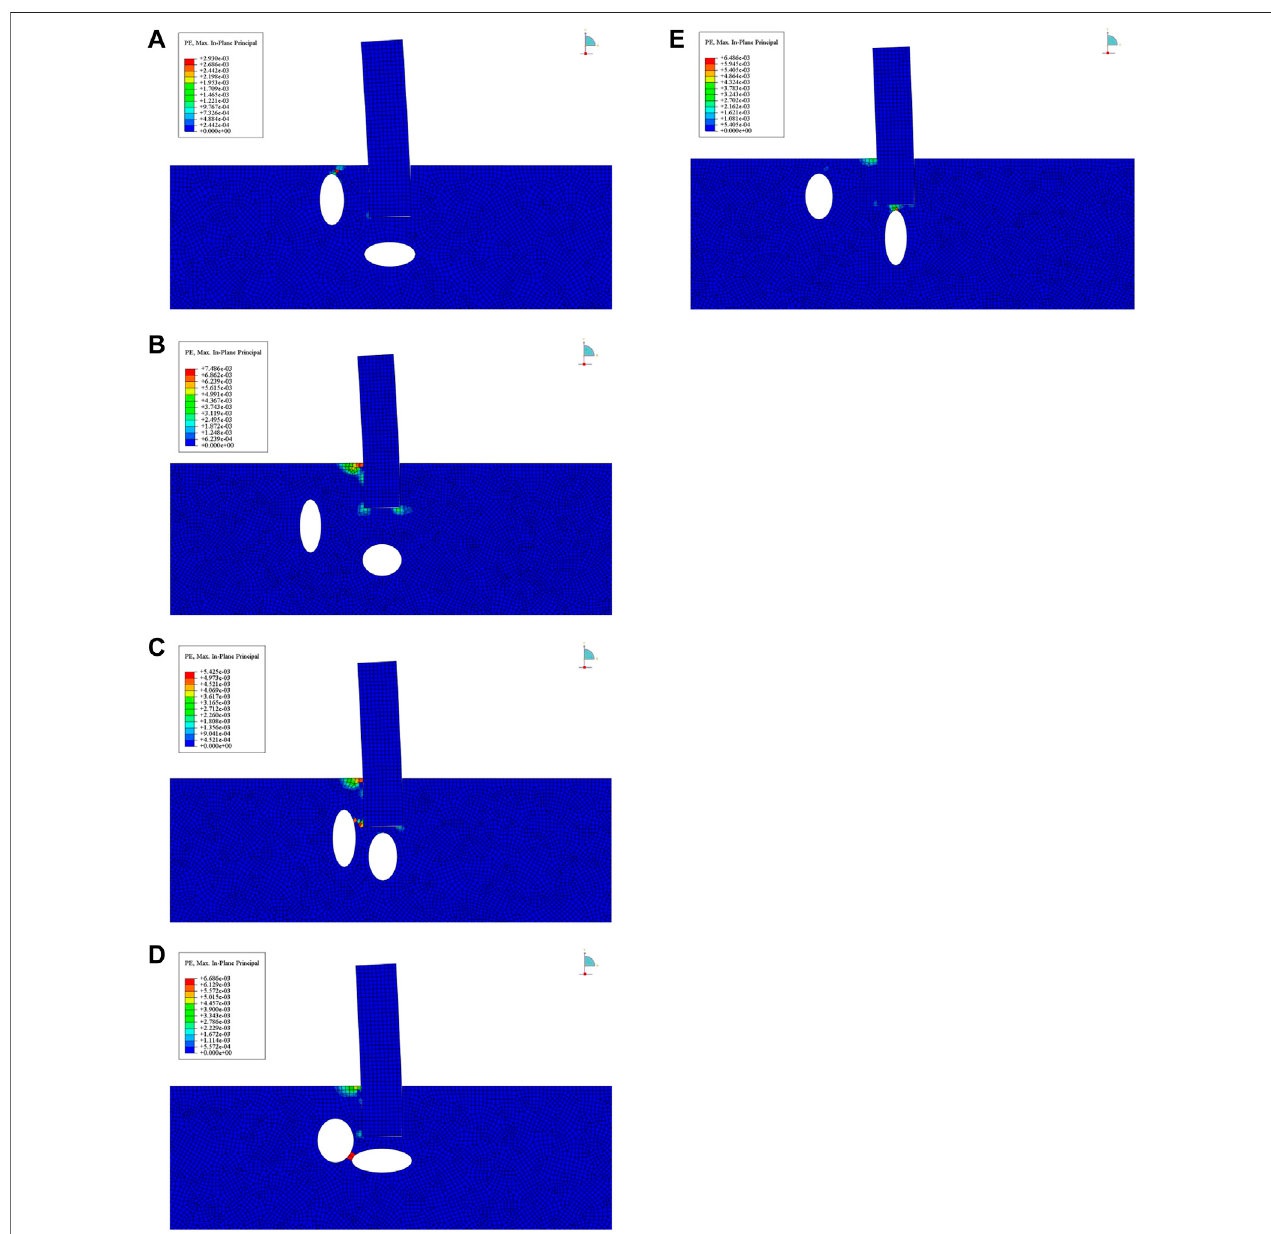
FIGURE 5 | Plastic strain distribution of the fi ve groups of tests outlined in the text.